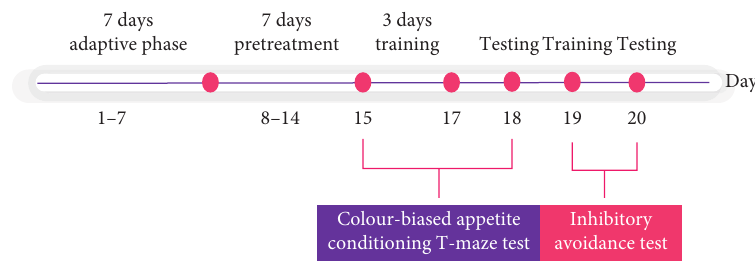
Figure 1: The experimental design of this study. Table 1: The contents of polyphenolic compounds in SA extract.